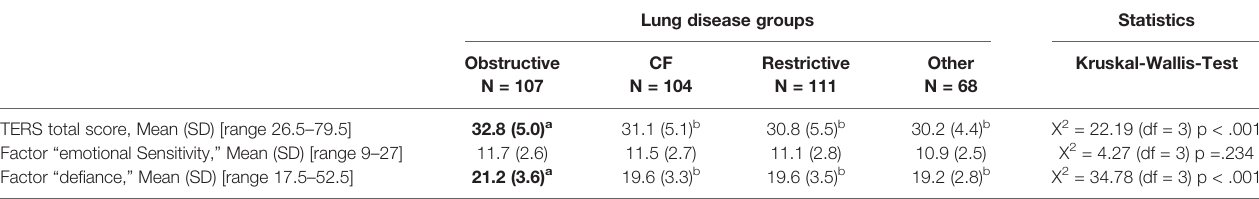
TABLE 5 | Comparison of TERS total score and subscales between lung disease groups.